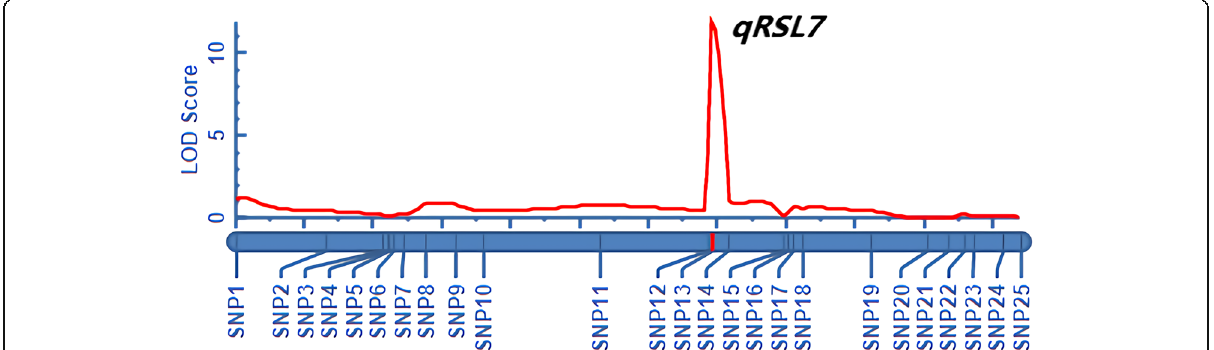
Fig. 7 qRSL7 detected in the F 2:3 population contained 199 lines by QTL ICIMapping4.2 software